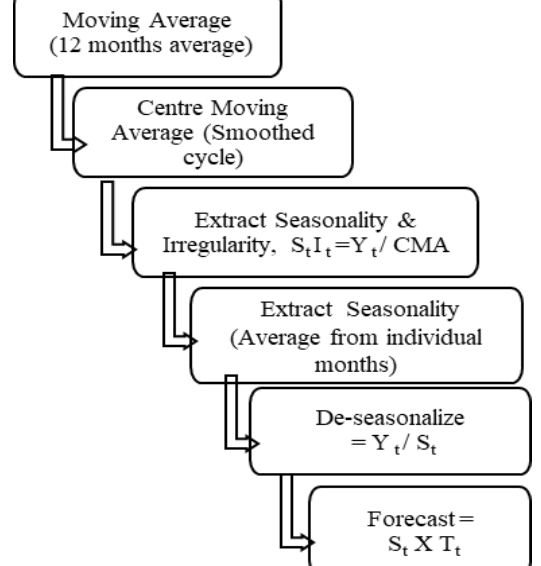
Figure 3: Detailed flowchart of steps followed in methodology i.e., time series analysis.